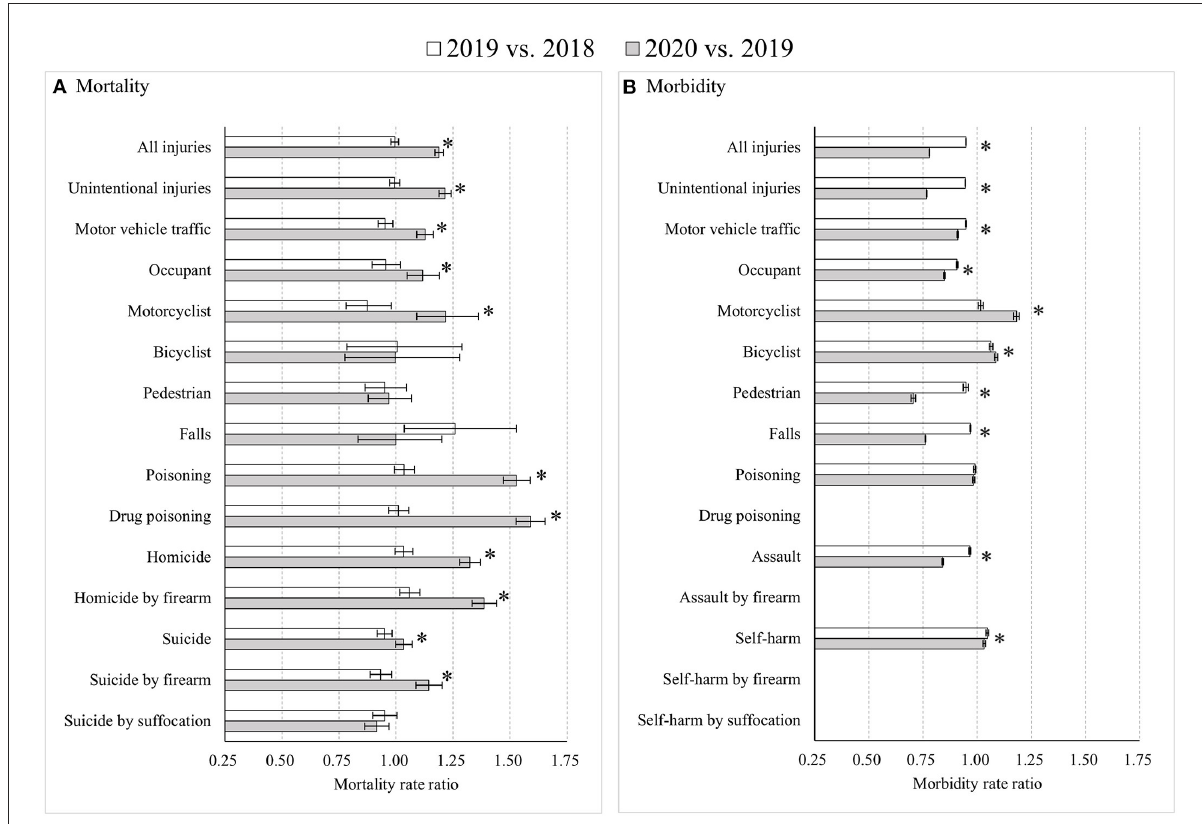
FIGURE2 Age-standardized injury mortality/morbidity rate ratios among Americans aged 0–24 years old, 2019 vs. 2018 and 2020 vs. 2019. (A) Mortality; (B) Morbidity. Results were omitted for categories having unstable injury morbidity rates (due to the computation based on cases < 20, the national estimates < 1,200, the coefficient of variation > 30%, or the tool not involving details regarding mechanism of relevant injury). “*” indicates that the differences of MtRRs or MbRRs between 2020 vs. 2019 and 2019 vs. 2018 were statistically